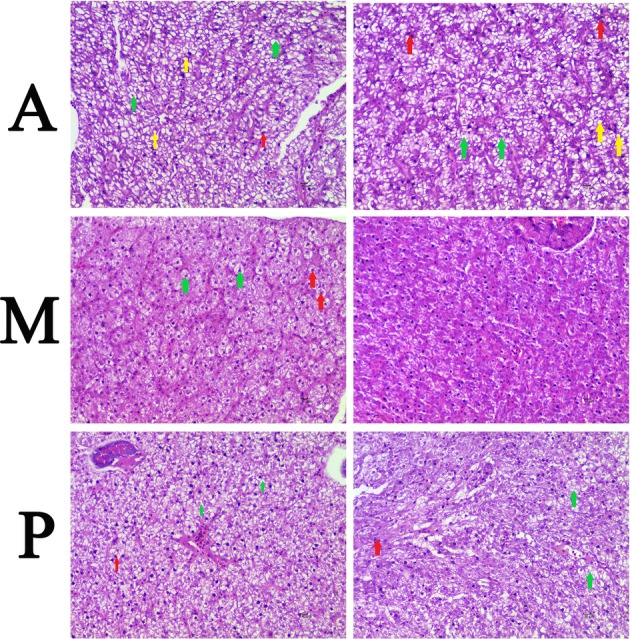
Hepatic histopathological changes of common carp fed with different types of diets (×400). (A) Common carp fed with earthworm. (M) Common carp fed with earthworm and duckweed. (P) Common carp fed with duckweed. Note: green arrow showing hepatocyte vacuole degeneration; yellow arrow showing fatty degeneration; and red arrow showing spotty necrosis.